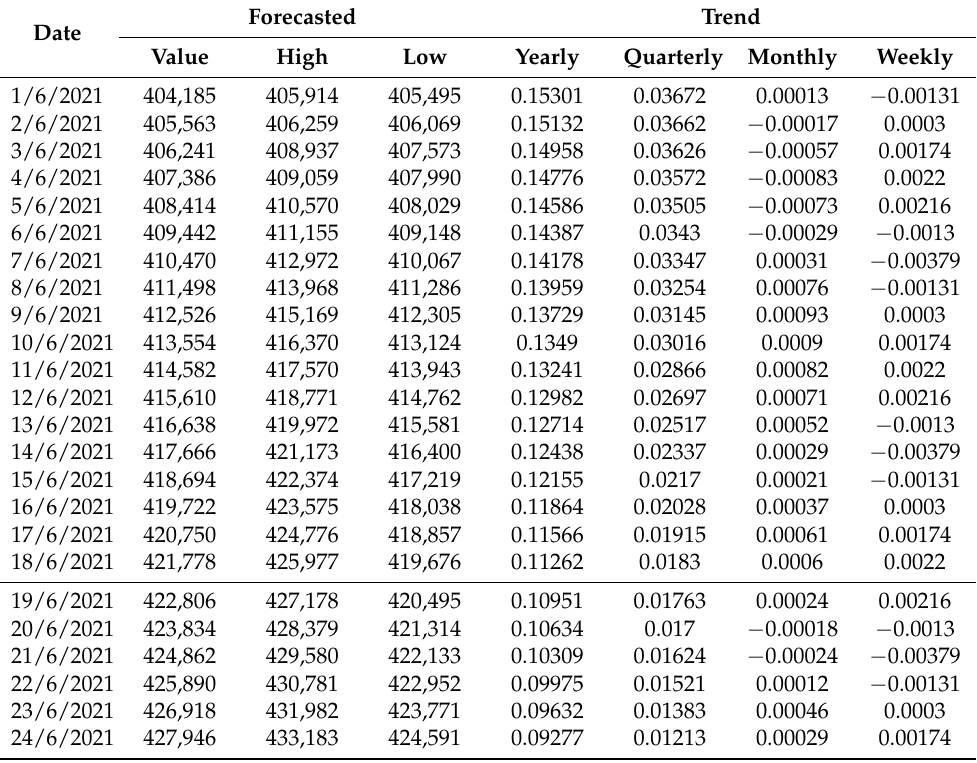
Table 8. Prophet forecast